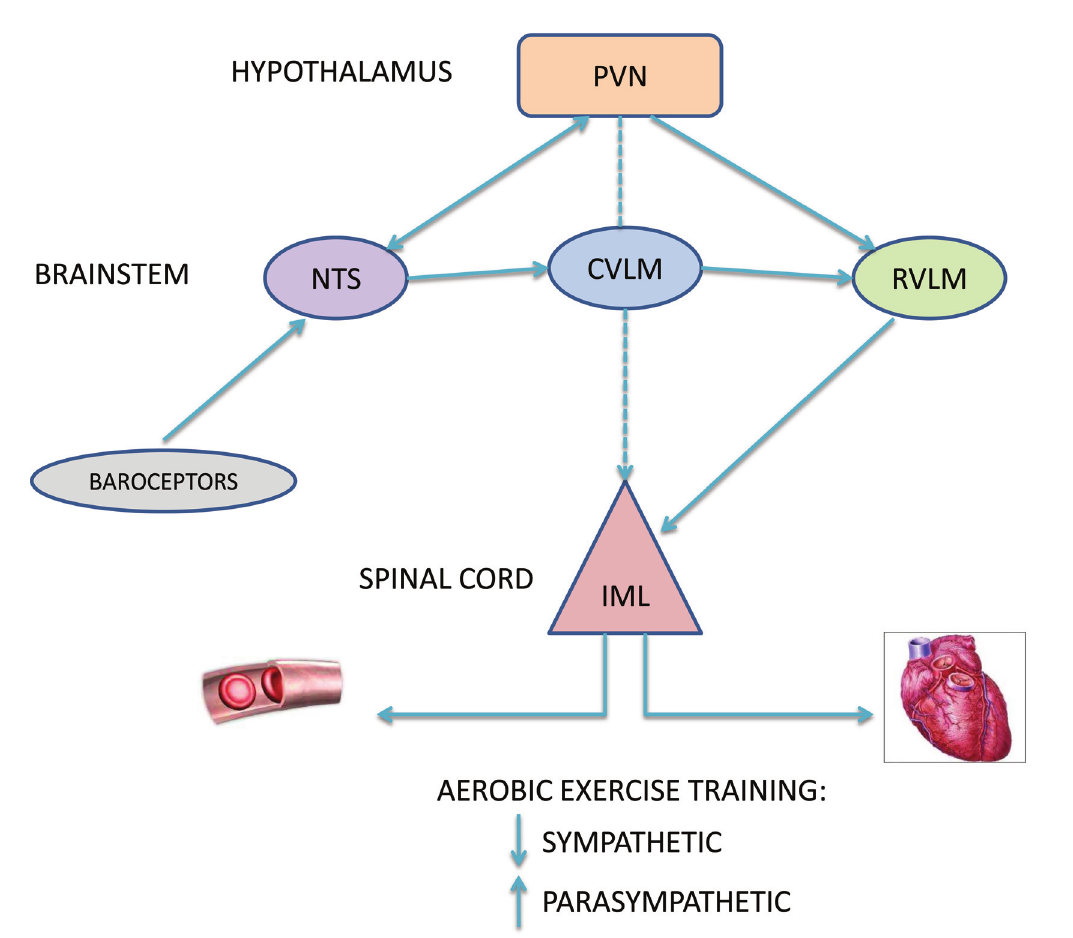
Figure 1. Representation of the hypothalamus and brainstem areas with their projections from baroreceptors, to each other (arrows indicate uni- or bidirectional pathways), and to the intermediolateral column (IML) of the spinal cord. The latter innervates the heart (sympathetic and parasympathetic systems) and blood vessels (only the sympathetic system) to maintain blood pressure and heart rate within normal limits. Aerobic exercise training appears to promote changes in these areas, leading to a lower sympathetic and increased parasympathetic tone. NTS = nucleus tractus solitarii; PVN = paraventricular nucleus of the hypothalamus; CVLM = caudal ventrolateral medulla; RVLM = rostral ventrolateral